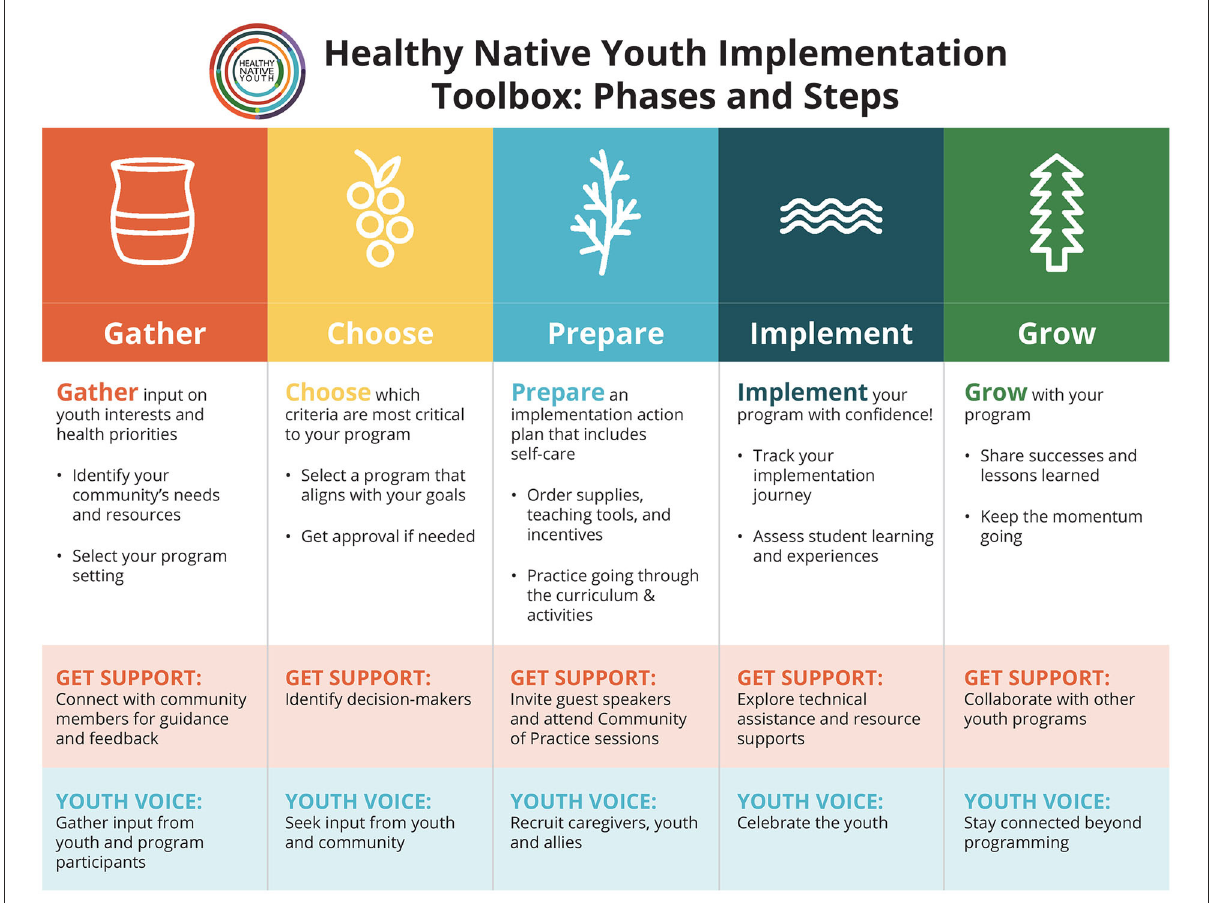
FIGURE4 Phases and steps in the Healthy Native Youth Implementation Toolbox